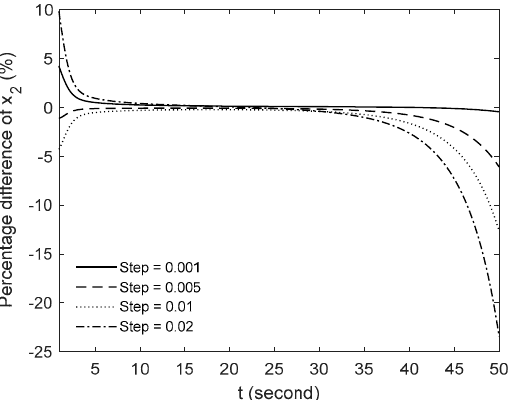
Figure 4. Percentage difference of x 2 between the exact solutions and the present method for different time steps h .